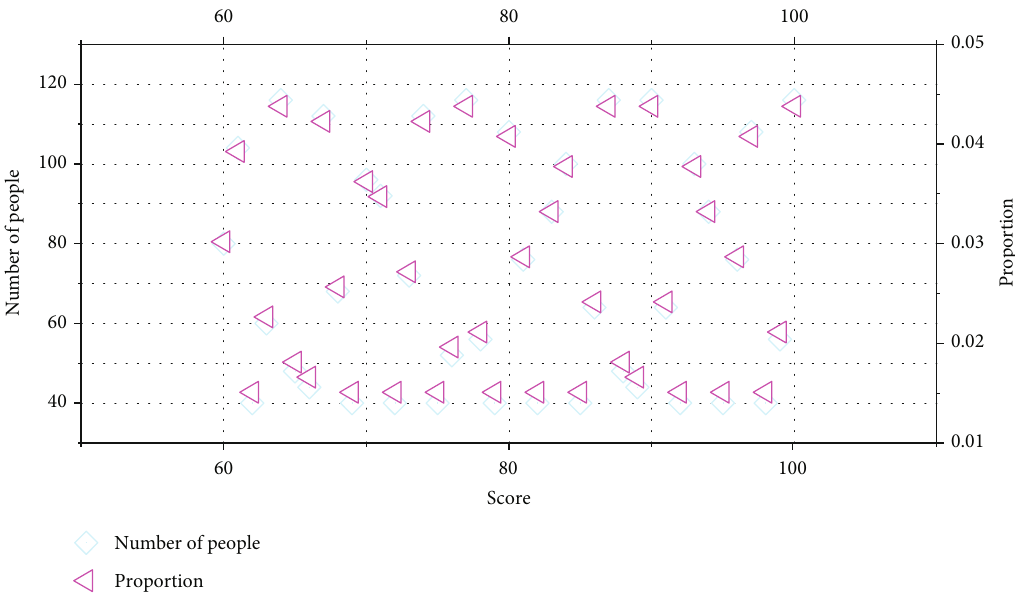
Figure 2: Statistics of people with di ff erent ratings of cultural atmosphere.